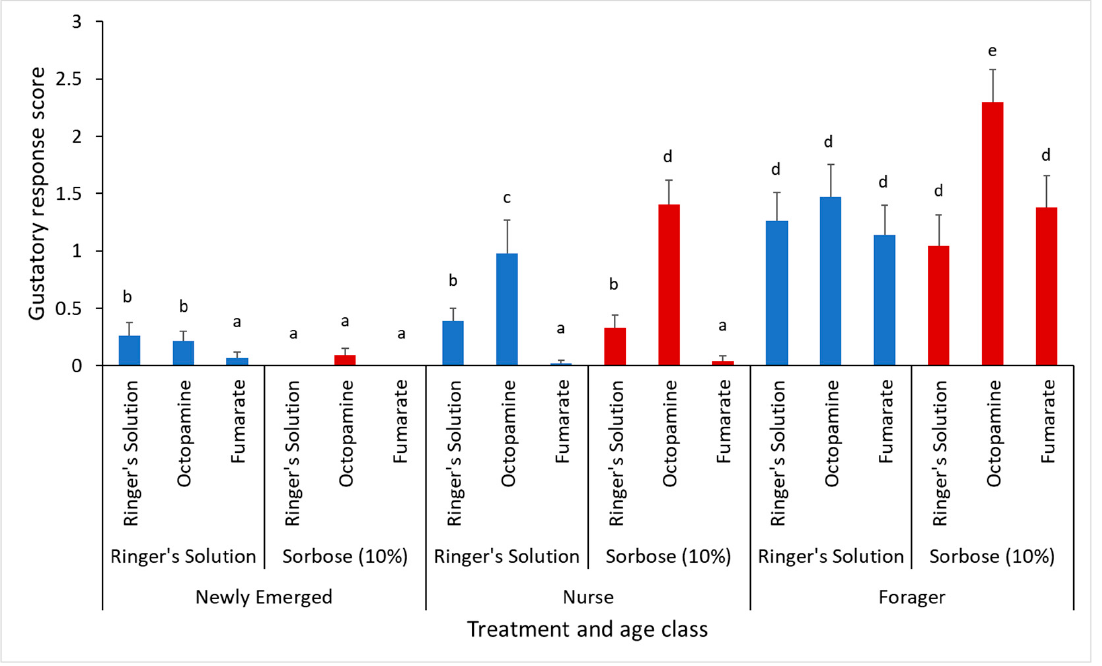
Figure 2. The gustatory response scores (GRS) measuring the appetite of the treated bees across the three age classes (newly emerged, nurse, and foragers). The control bees of each age class are indicated with blue bars and the bees treated with 10% sorbose are indicated in red. Each bar represents the mean GRS, while the error bars represented the standard error. The letters above each bar represent significant differences at the alpha = 0.05 level.